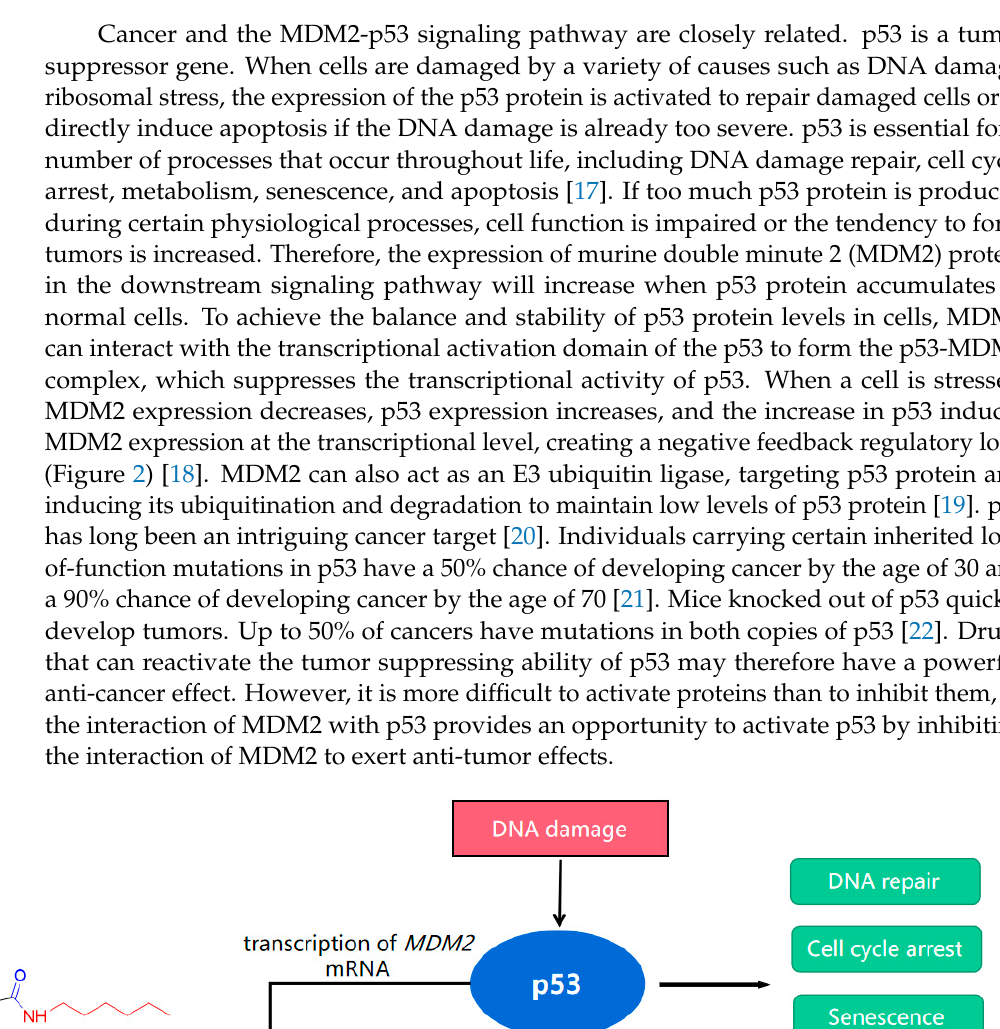
Figure 1. The structure of GAA and compound A2 .